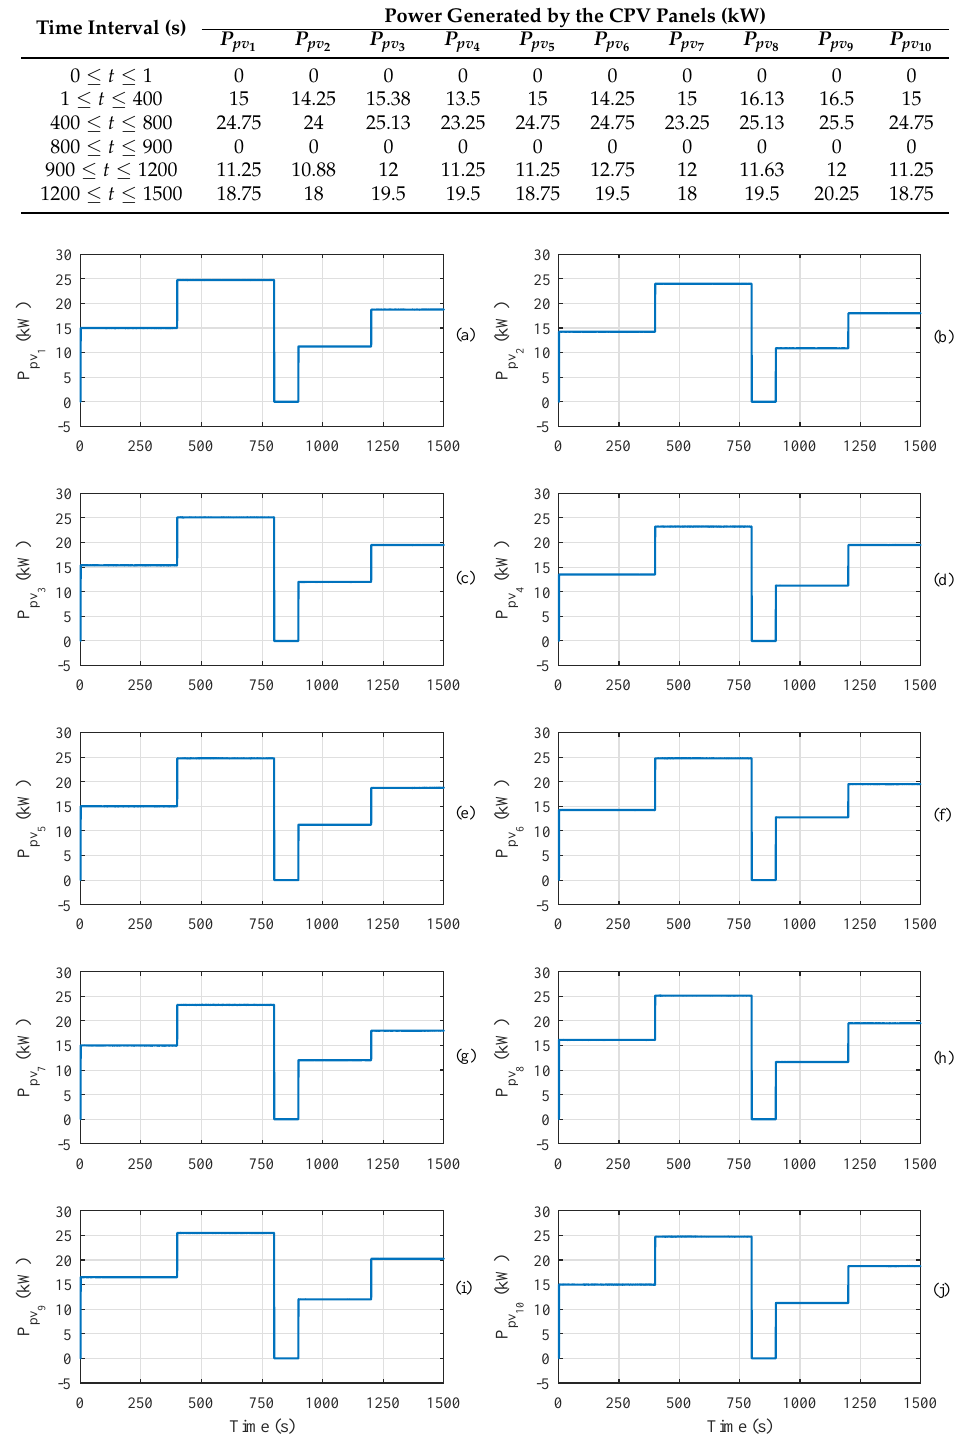
Figure 12. Time responses of the power generated by the 10 concentration photovoltaic (CPV) generators of the PV plant. ( a ) p pv ( i ) p pv ; and ( j ) p pv 9